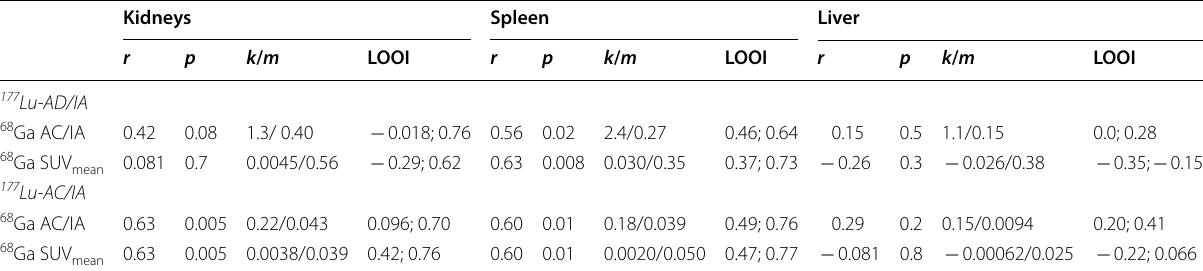
Table 1 Results for organs of the 177 Lu-AD/IA and 177 Lu-AC/IA, as a function of two 68 Ga-PET-derived